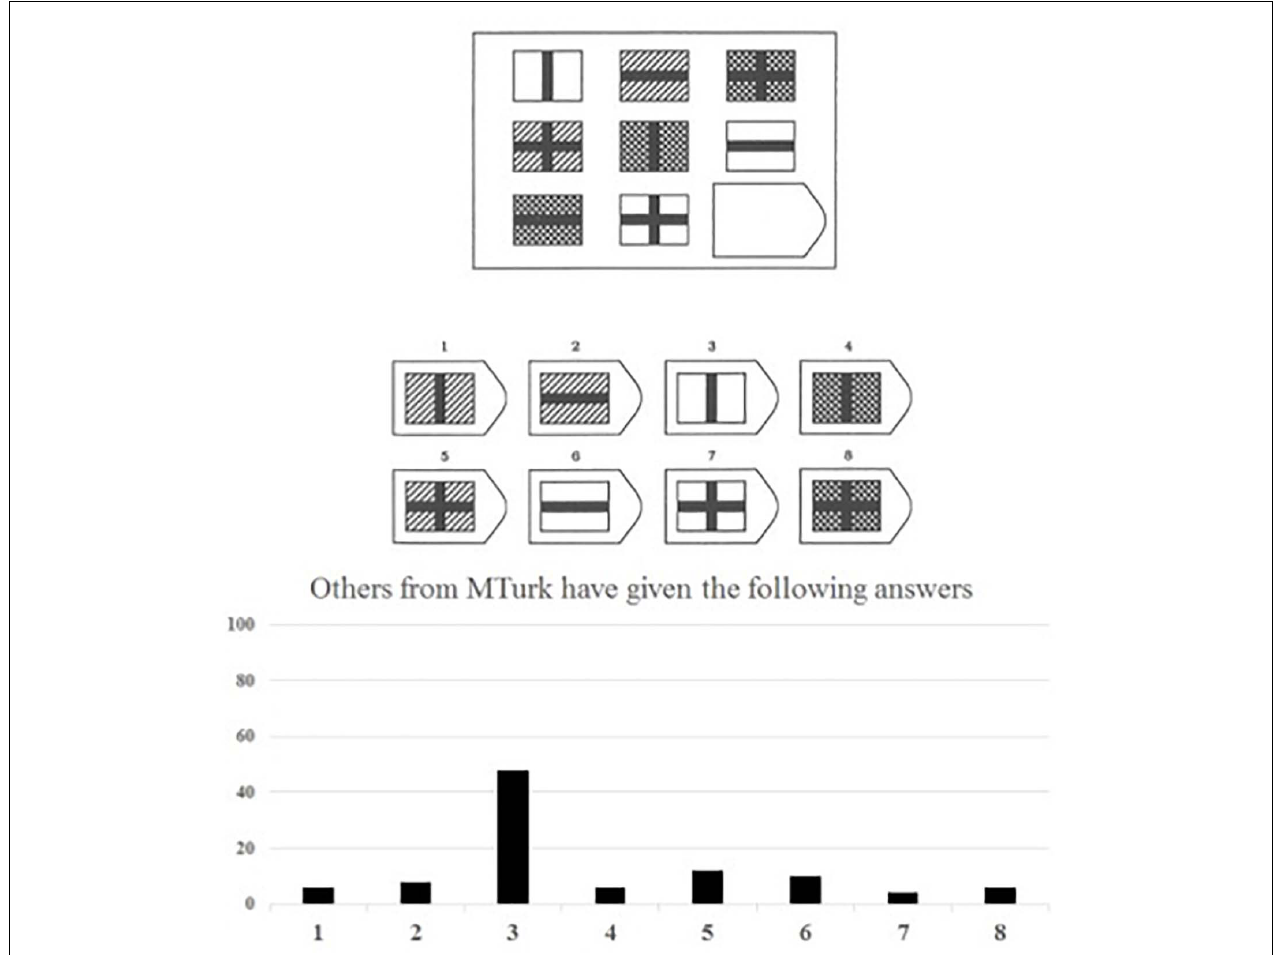
FIGURE 2 | Example of logical reasoning item (Item 4) with the fabricated diagram shown to the conformity